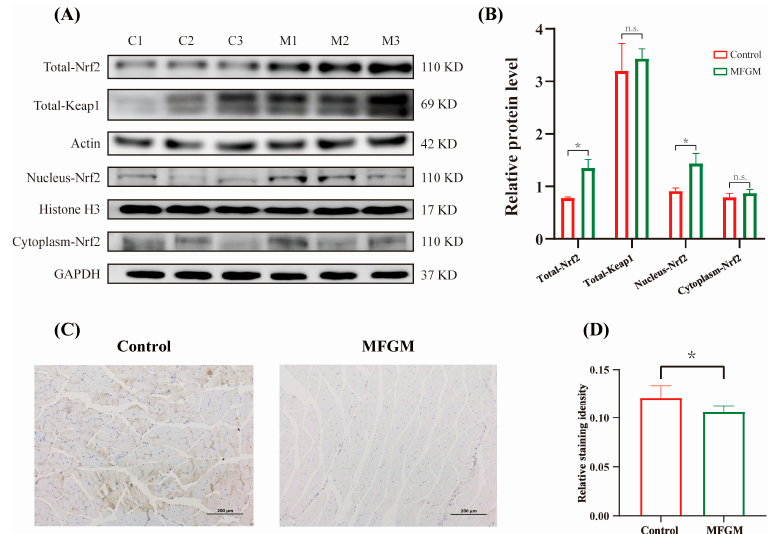
Figure 4. Effects of milk fat globule membrane on protein expressions in the muscle and liver of the mice at 18 weeks: ( A ) Western blot of nuclear and cytoplasmic nuclear factor erythroid 2-related factor 2 (Nrf2) and total Kelch-like ECH-associated protein 1 (Keap1); ( B ) quantification analysis of total Nrf2, total Keap1, nucleus-Nrf2, and cytoplasm-Nrf2; ( C ) immunohistochemical analysis of gastrocnemius muscle in the Control and MFGM groups; and ( D ) average optical density of Caspase-3 in the two groups. C1, C2, and C3 belong to the Control group, whereas M1, M2, and M3 belong to the MFGM group. The data are expressed as mean ± SD, n = 3, * p < 0.05, n.s.: no significance. Control: fed with saline; MFGM: fed with 400 mg/kg BW milk fat globule membrane.